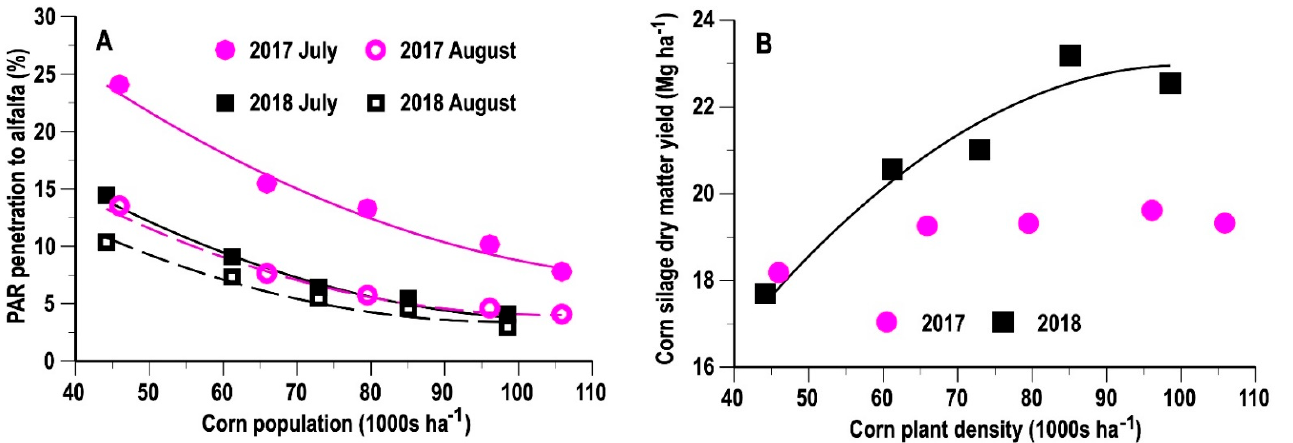
Figure 1. Penetration of photosynthetically active radiation (PAR) through the corn canopy to interseeded alfalfa in July and August ( A ) and corn silage yield in September ( B ) as influenced by production year and corn plant population. Data were averaged across alfalfa varieties and agrichemical treatments. Regression intercepts and slopes of PAR measured in July and in August and of corn yield differed between years ( p = 0.05).